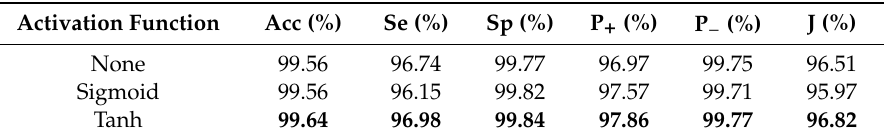
Table 8. Test the activation functions.